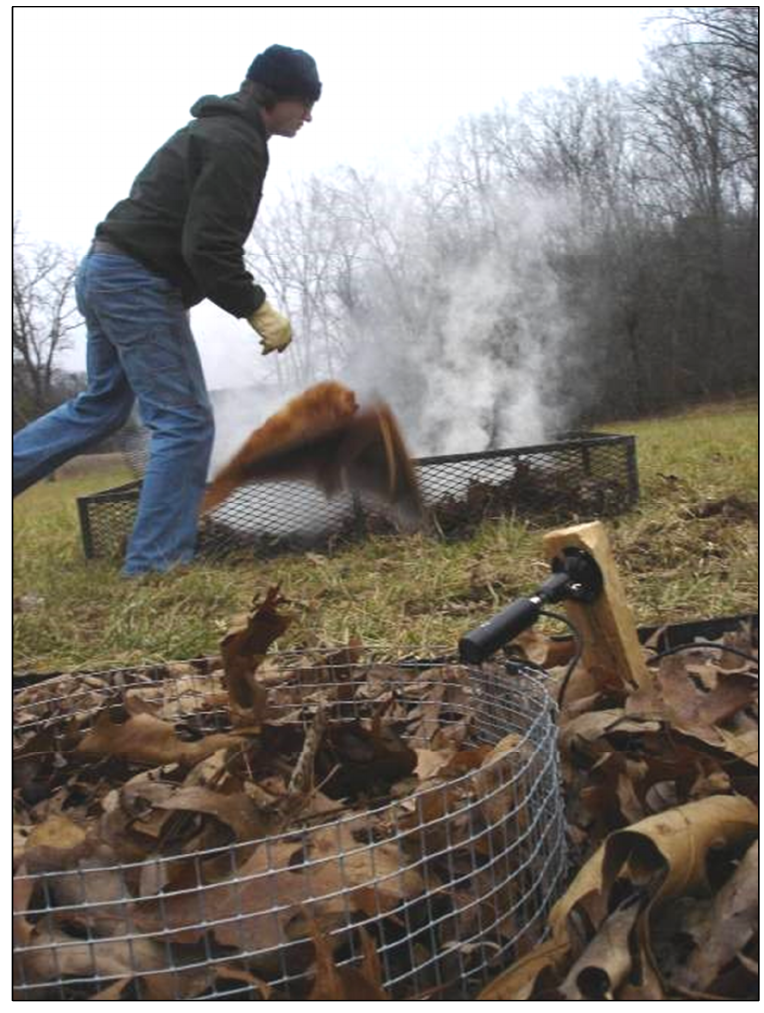
Figure 3. Eastern red bat taking flight during field trial.